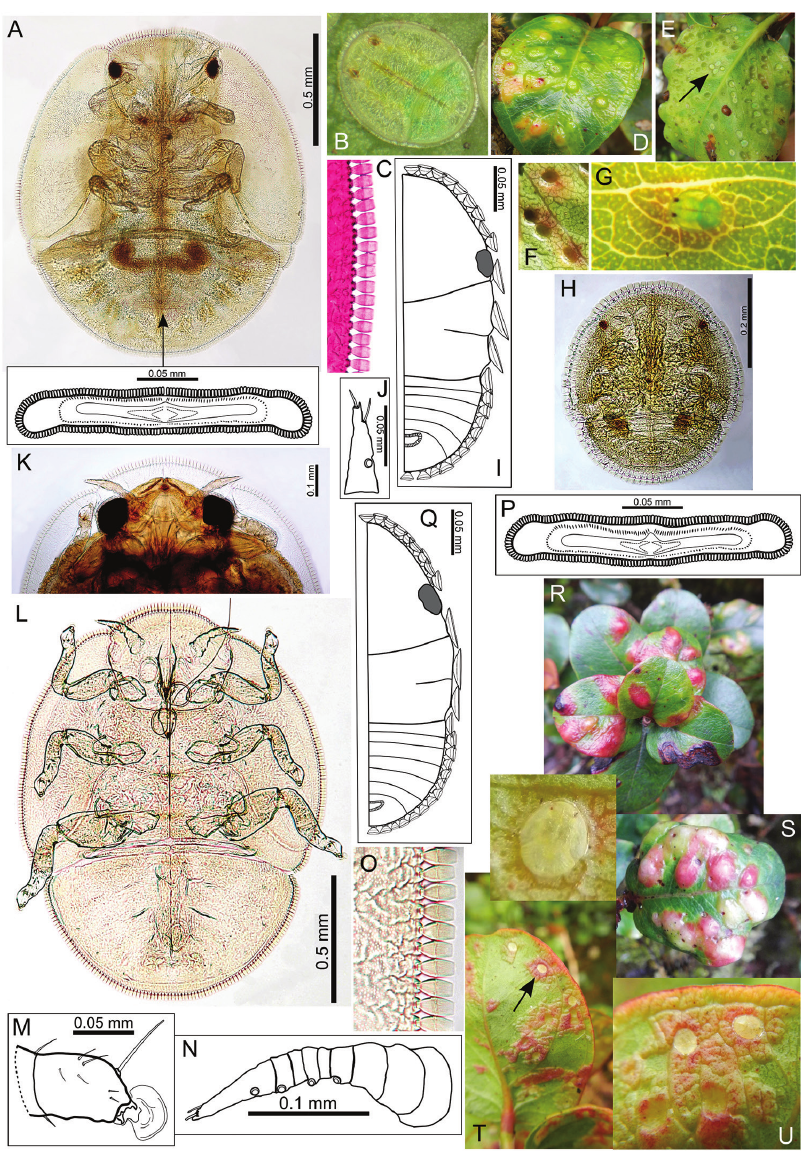
Figure 47. Pariaconus dorsostriatus and Pariaconus namaka immatures. A–J P. dorsostriatus : A 5 th instar with anal ring detail (inset) B detail of immature seated in pit C detail of marginal sectasetae (5 th instar, stained) D raised impressions on upper leaf surface from pit galls on lower leaf surface E immatures inside pits on lower leaf surface F empty pits on lower leaf surface G immature on lower leaf surface H 2 nd instar I 1 st instar J terminal antennal segment K–U P. namaka : K 5 th instar (uncleared) showing overhang of sclerotized dorsal surface beyond ventral body L 5 th instar M tarsi N antenna O detail of marginal secta- setae P anal ring (5 th instar) Q 1 st instar R, S raised impressions on upper leaf surface from pit galls on lower leaf surface T immatures inside pits on lower leaf surface with detail of immature (inset) U detail of immatures seated in pits with discoloured raised gall tissue around